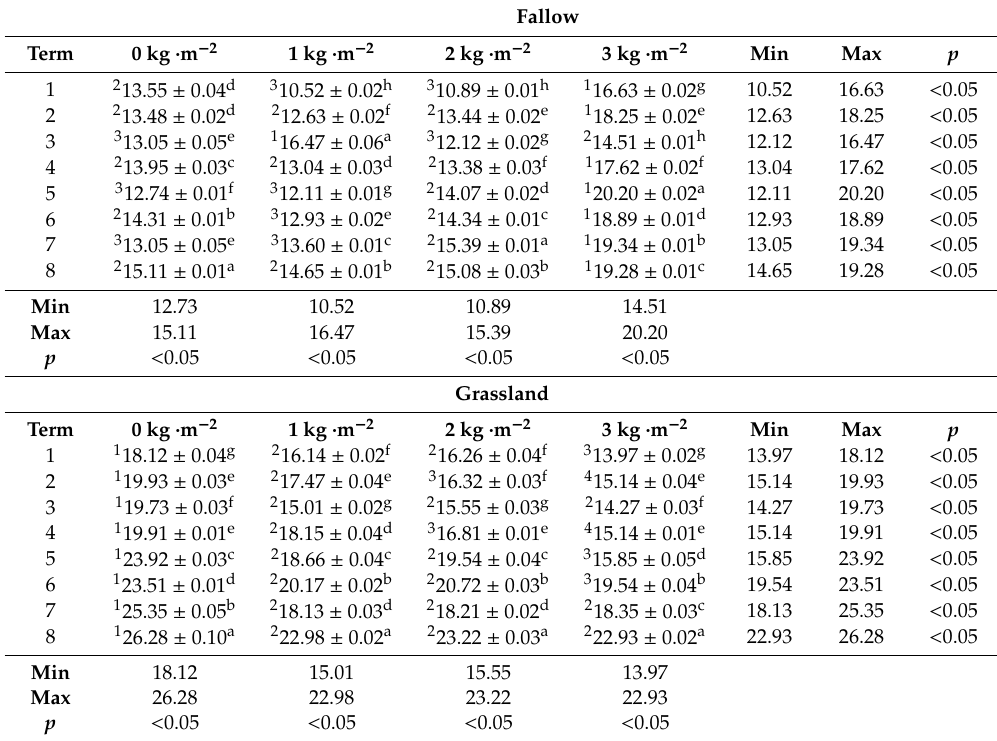
Table 3. Changes in values of total volume of micropore (V, µ l · g − 1 ) in soil samples collected from fallow and grassland amended with BioC (0, 1, 2, 3 kg · m − 2 ) in terms: 1 st –8 th . Average values from 3 replicates in each term. Other letter designations (a, b, c, d, e f, g, h) indicate significant di ff erences (between values at p < 0.05) in terms. Other numbers designations (1, 2, 3) indicate significant di ff erences (between values at p < 0.05) among treatments for the same sampling date. Fallow